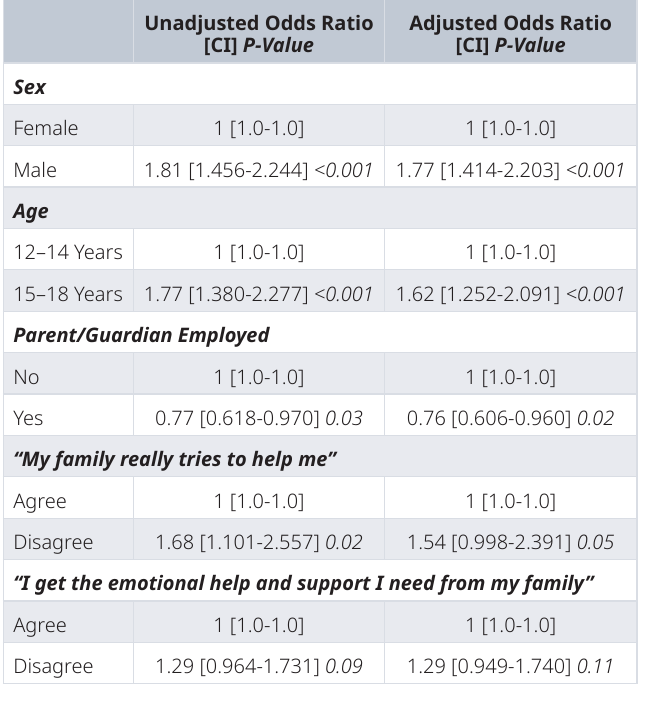
Table 5. Unadjusted and adjusted regression models for predictors of current substance